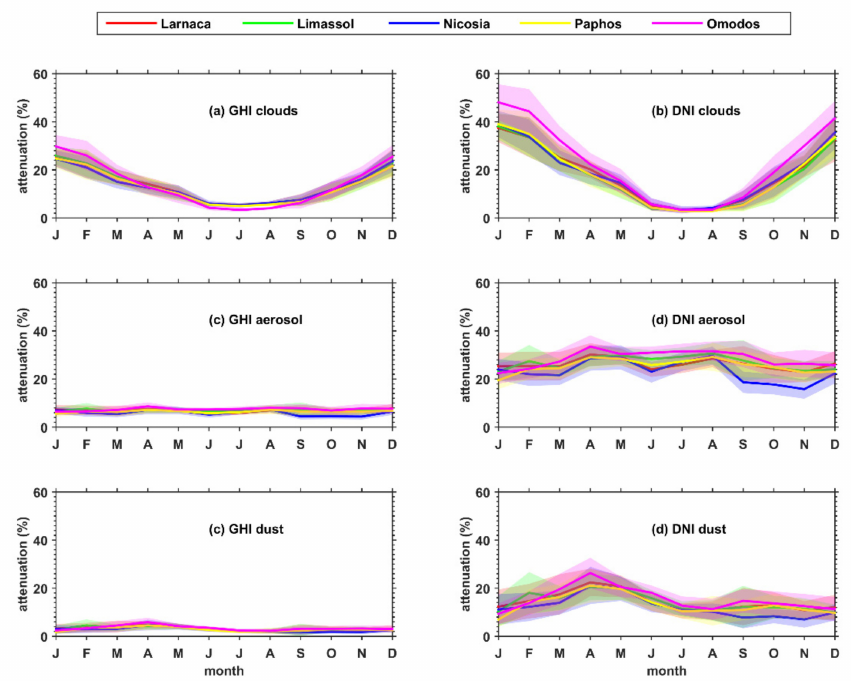
Figure 7. Attenuation of the monthly GHI and DNI (in %) by clouds, aerosols, and dust aerosols (climatological monthly averages for 2004–2017). ( a ) GHI clouds, ( b ) DNI clouds, ( c ) GHI aerosol, ( d ) DNI aerosol, ( e ) GHI dust, (f) DNI